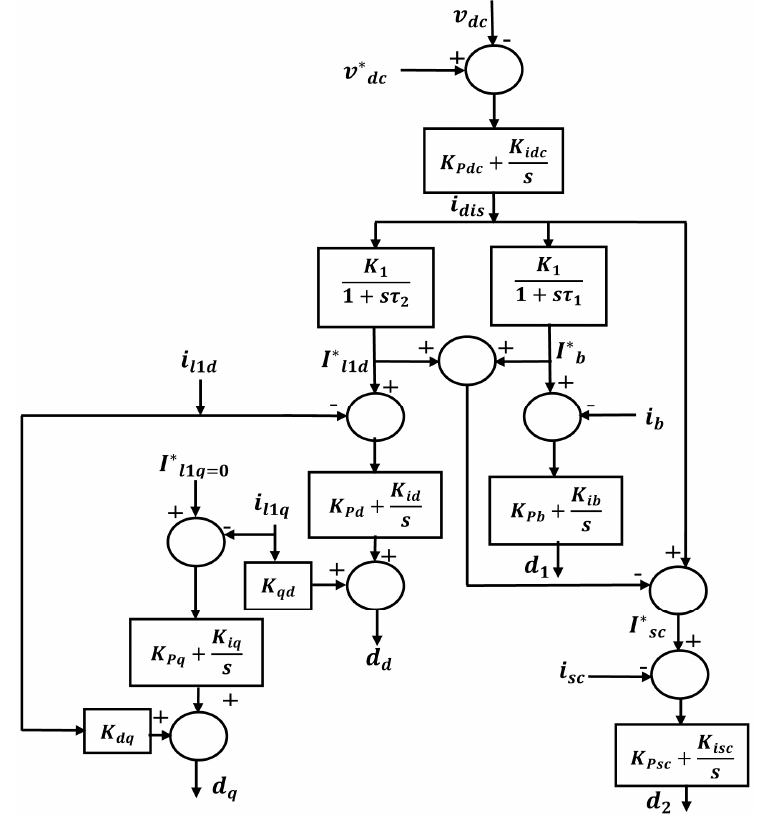
Figure 2 . Proposed control system for hybrid storage system and network-interface converter. Figure 2. Proposed control system for hybrid storage system and network-interface